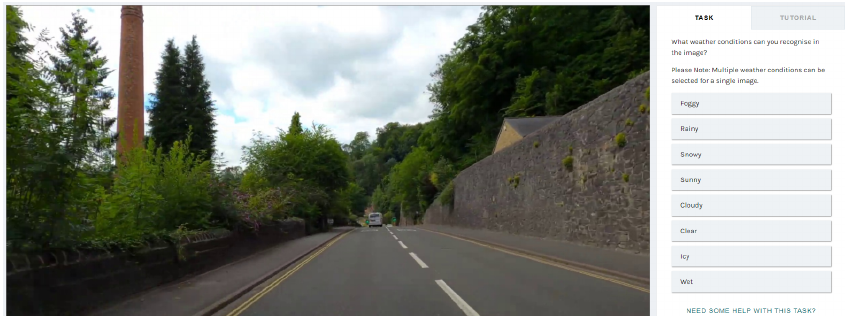
Figure 4. A screenshot of using Zooniverse to annotate road weather